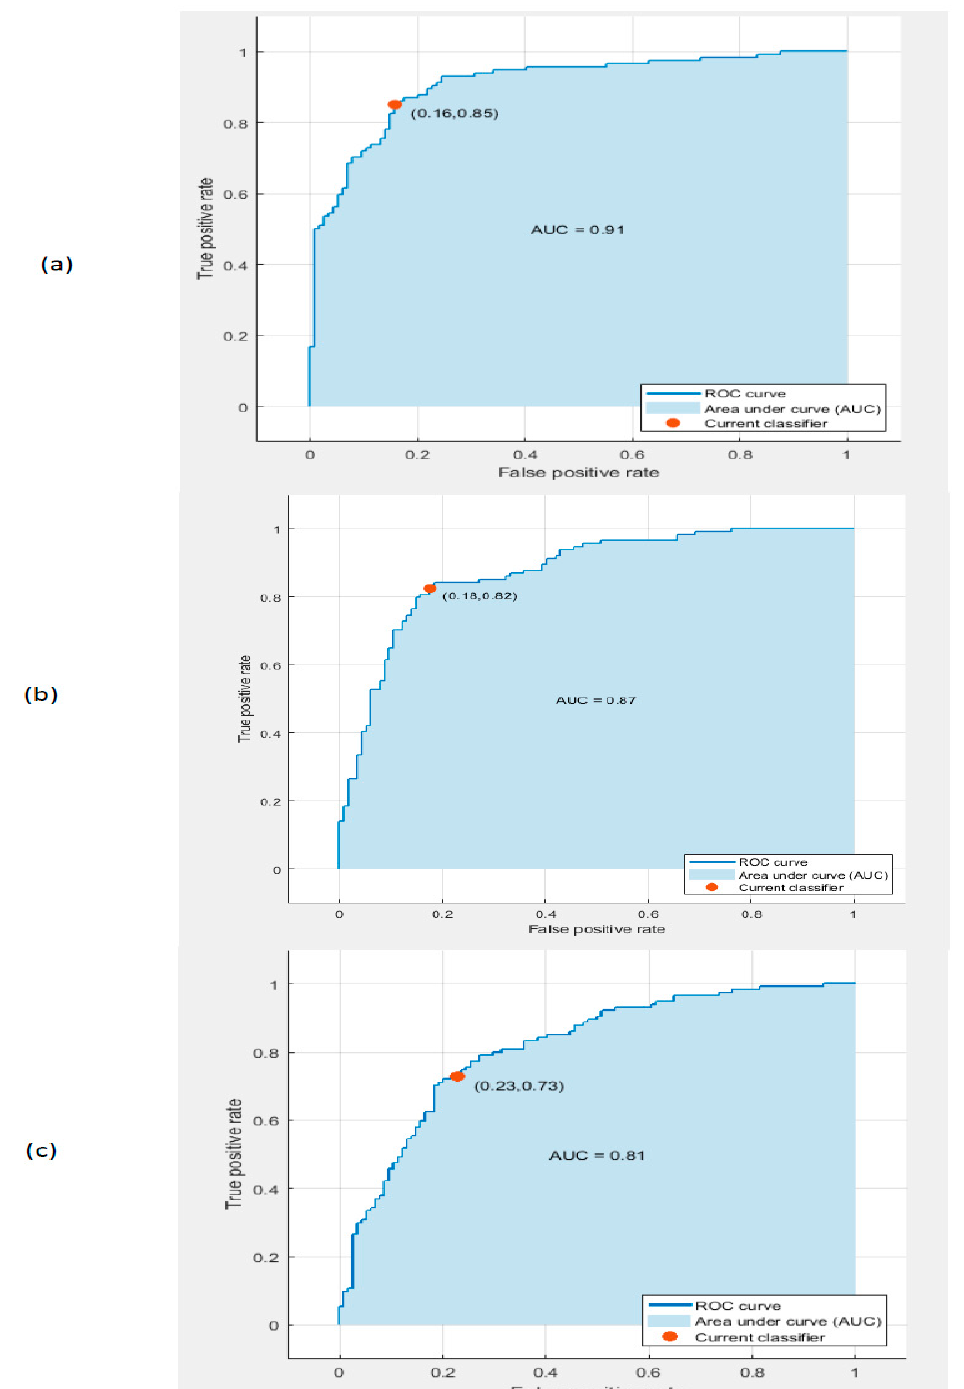
Figure 7. The figure shows that the areas under the curve (AUCs) for the GoogleNet, AlexNet, and ResNet 50 DCNNs were 0.91, 0.87, and 0.81, respectively. Diagnostics 2019 , 9 , x FOR PEER REVIEW